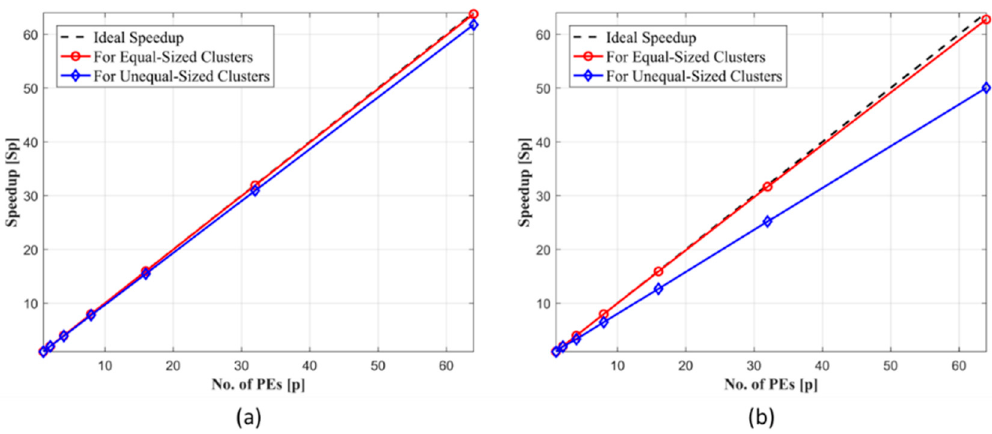
Figure 8. ( a ) Comparison of speedup for same size of data but having equal and unequal cluster sizes ( b ) Comparison of speedup for equal and unequal sized clusters but data size is same for both cases. Effect of Build Phase is not included.